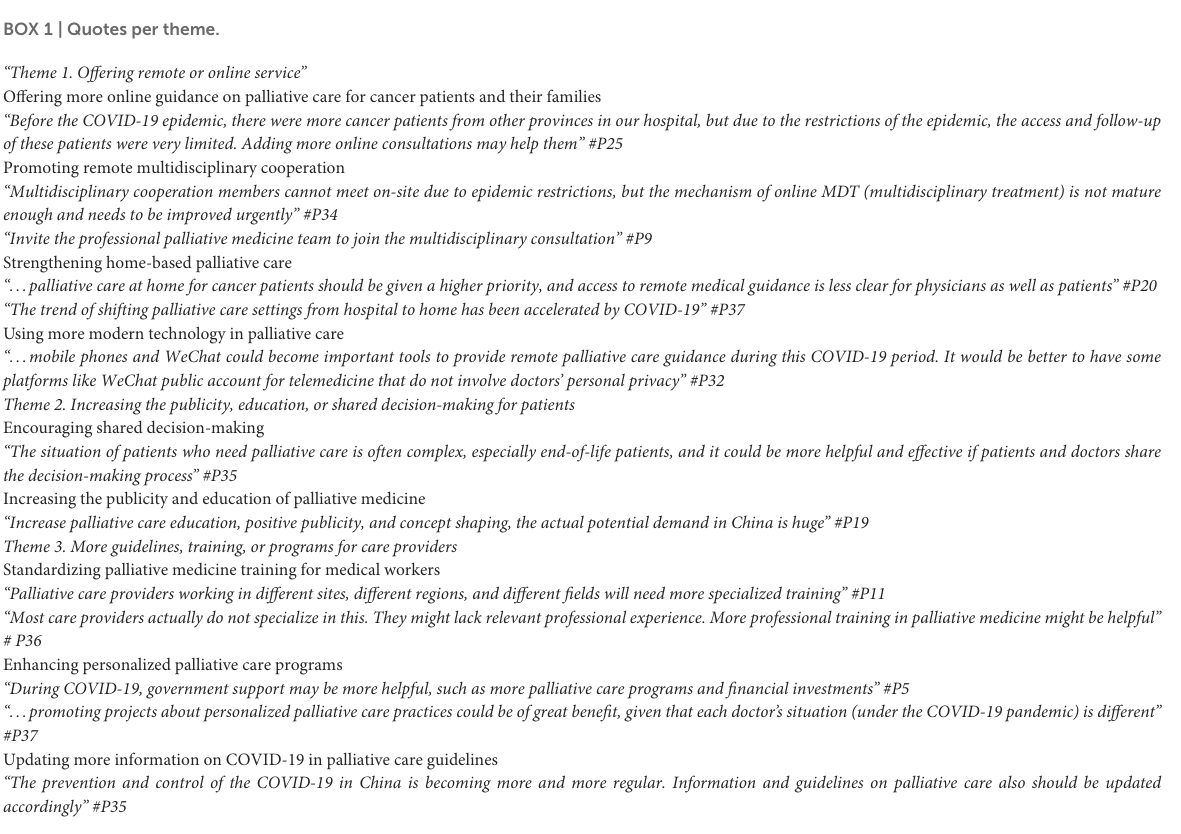
BOX 1 | Quotes per